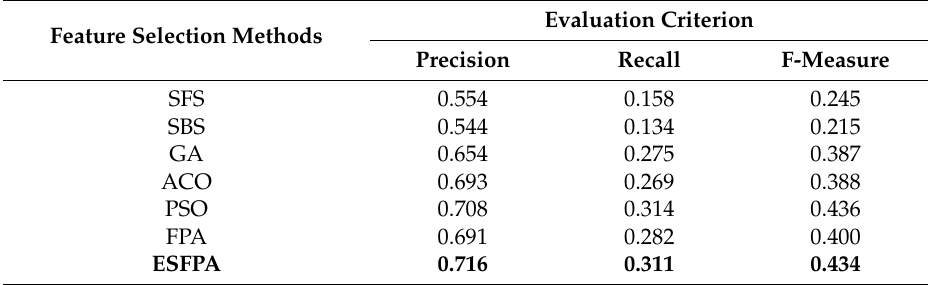
Table 2. Comparing the performance of different feature selection methods on imbalanced dataset.